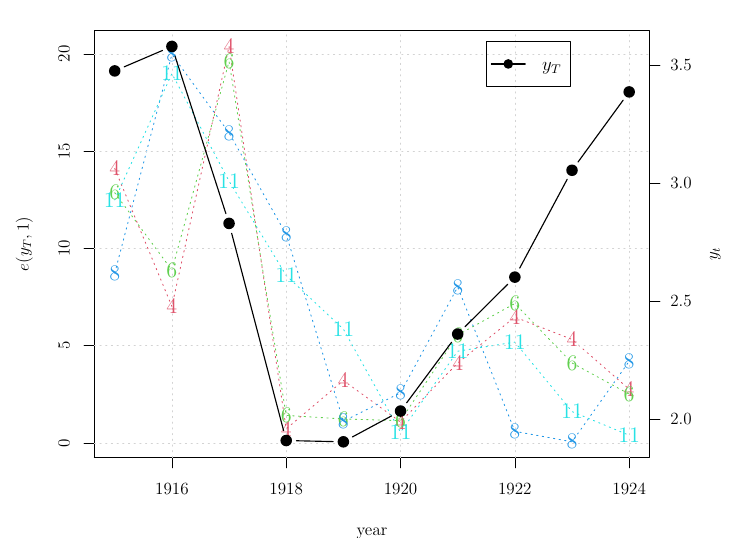
, h = 1 ) versus y when the forecasting horizon is fixed to 1 for the models Figure 13 – Plot of e ( y T T M4, M6, M8 and M11. The black line is the observed series and each bullet represents y 1915,...,1924, i.e. the end point of each training